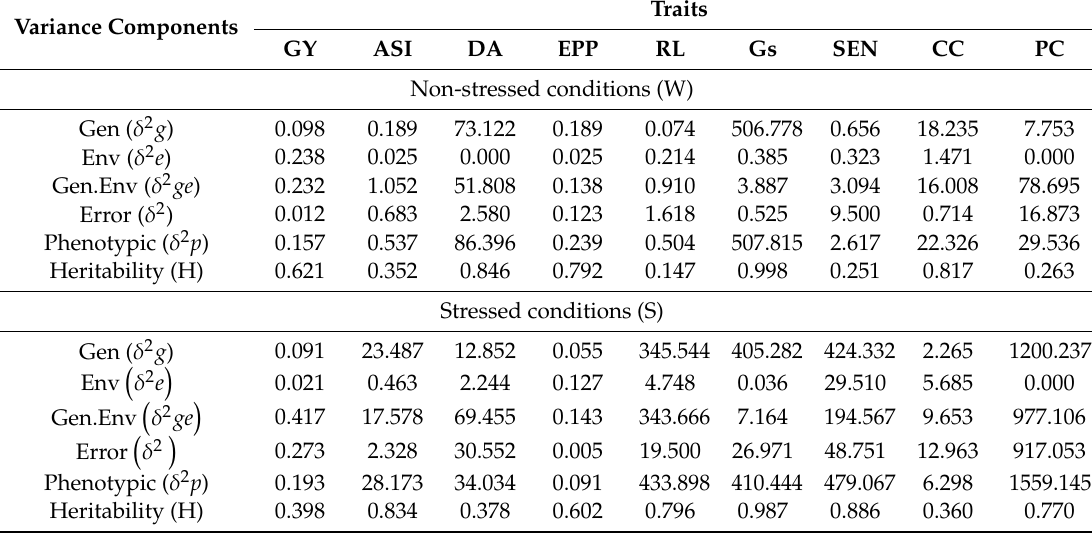
Table 3. Variance components and heritability of measured morphophysiological